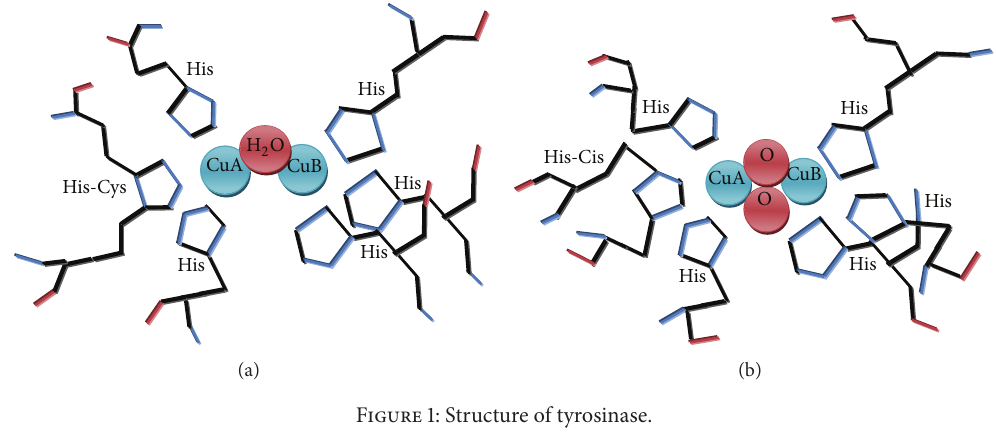
Figure 1: Structure of